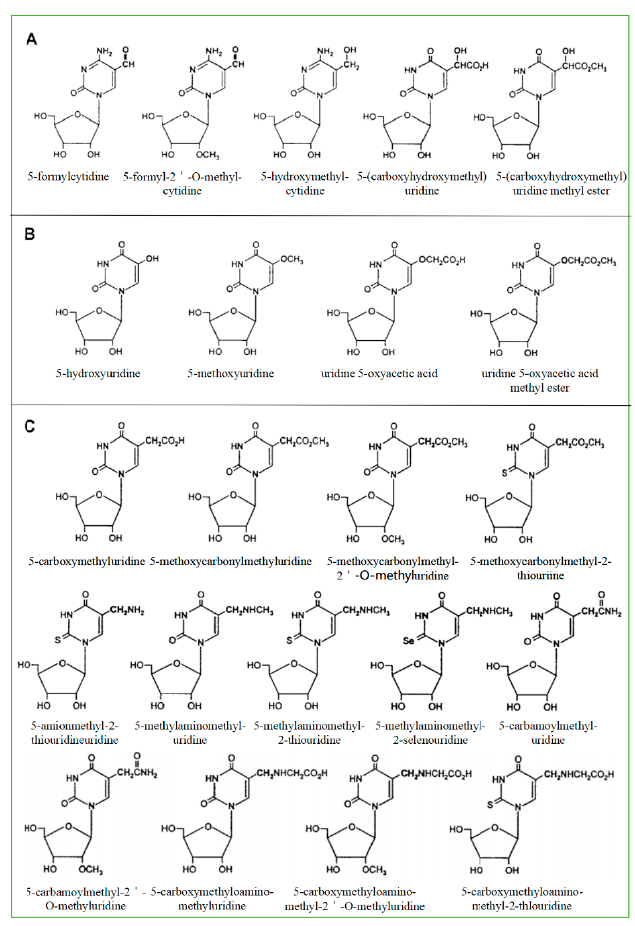
Figure 1. Modified pyrimidine nucleosides found in tRNA. They are divided into three subgroups according to possible factors: formylcytosine ( A ), hydroxyuridine ( B ), and carboxyuridine ( C ).